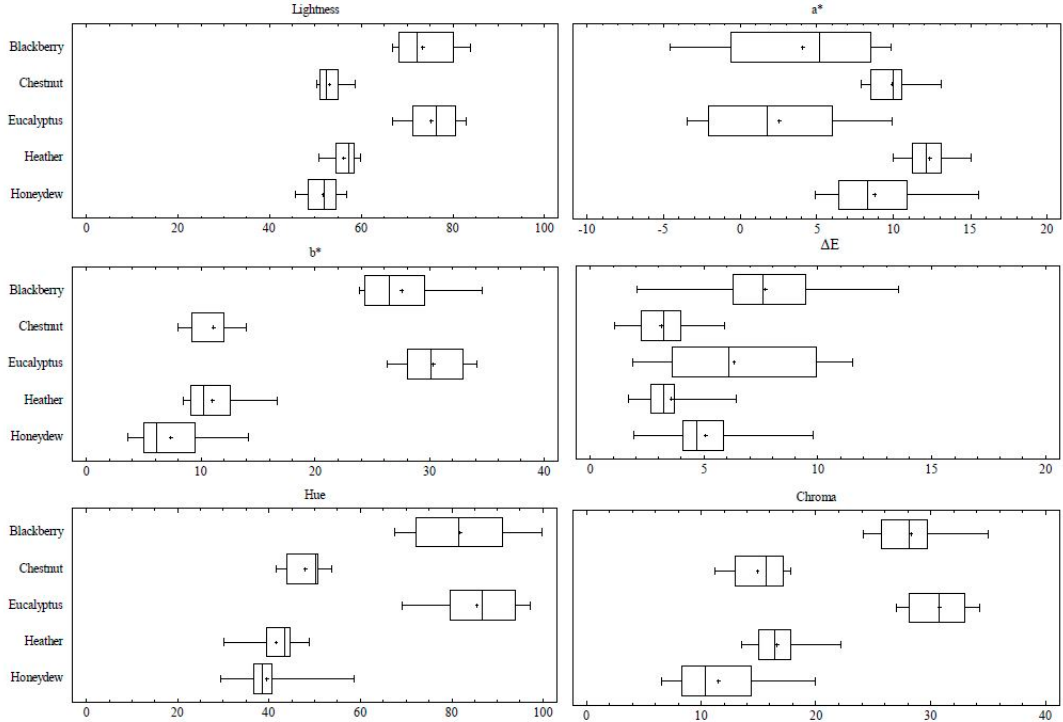
Figure 2. Box-Plot diagram of CIELab coordinates (L, a*, b*), ∆ E, Chroma and Hue. L represents lightness (L = 0, black, and L = 100, colorless), a* green / red color component (a* > 0, red, and a* < 0, green), and b* blue / yellow color component (b* > 0, yellow, and b* < 0, blue).